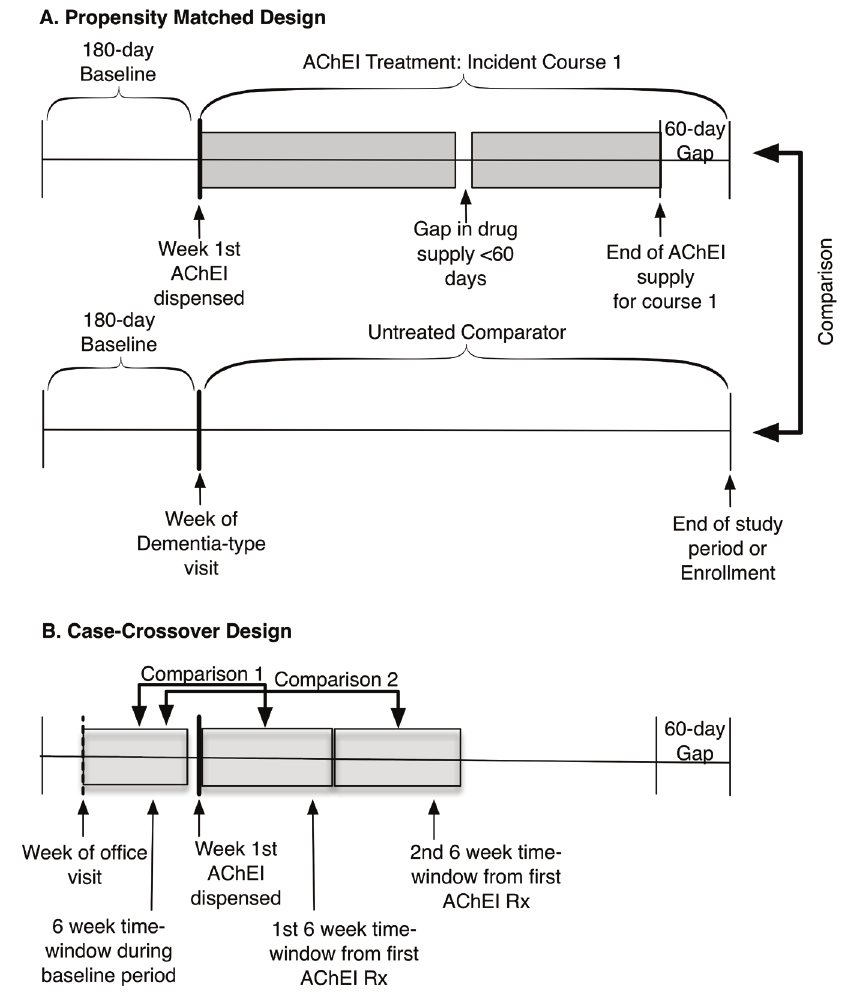
Figure 1. Treatment time-windows for cohort and case-crossover study. AChEI = Acetylcholinesterase inhibitors. Rx = Dispensed Prescription. The untreated comparison group consisted of Medicaid recipients 50 years and older with a dementia-like diagnosis who did not receive AChEI therapy. We established a 180-day baseline period during which recipients were enrolled and had at least one medi- cal claim. The index date for individuals in the untreated group began at the first dementia-related outpatient visit that allowed for a 180-day baseline period. Starting time zero with a dementia-related outpatient visit established an indicated population that was engag- ing the health care